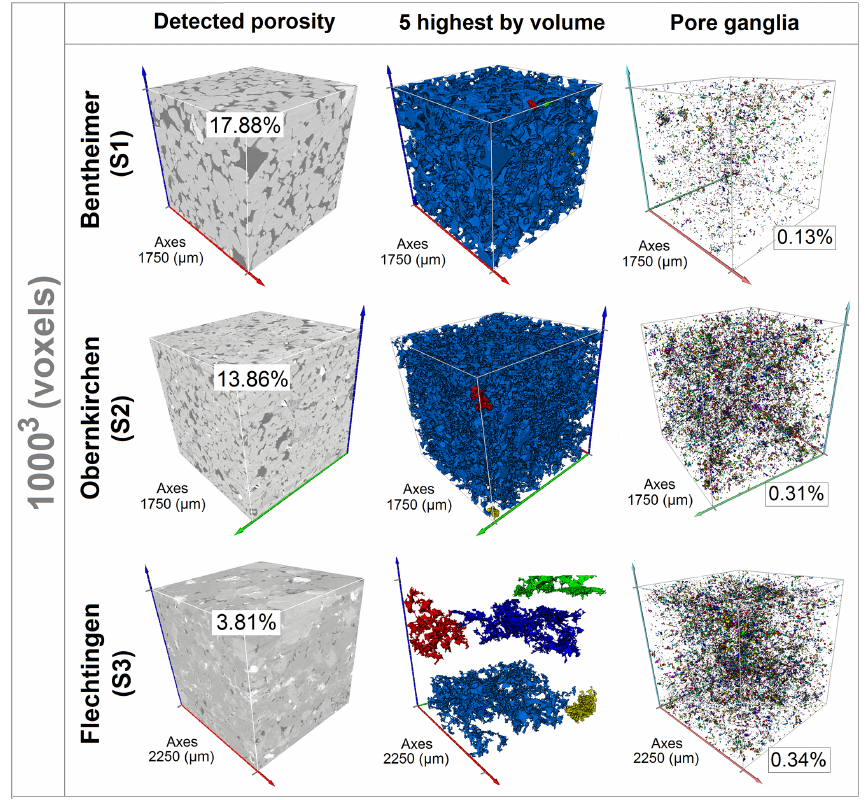
Figure 3. 1000 3 voxel renderings of the analyzed sandstones: grayscale image (a) , five biggest (by volume) main pore networks (b) , and residual pore ganglia that were excluded from the shape analyses (c) . In (b) and (c) , the labeled images show distinct colors for dissimilar